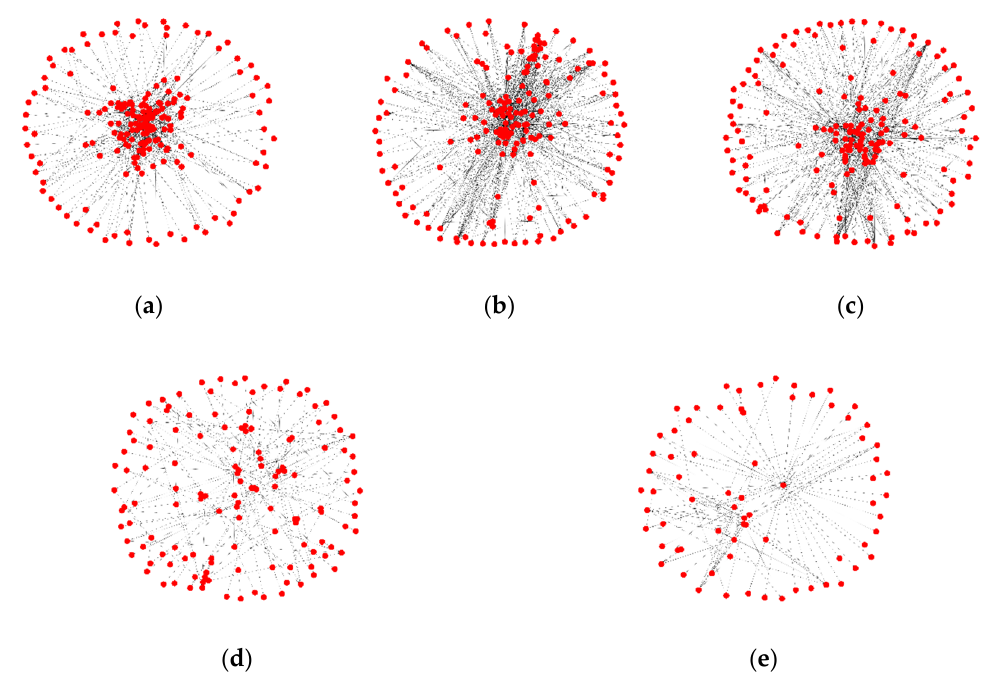
Figure 2. Interaction graphs with five different relationships. Graphs ( a – e ) for the interaction graph with relationship (1) to (5), respectively.